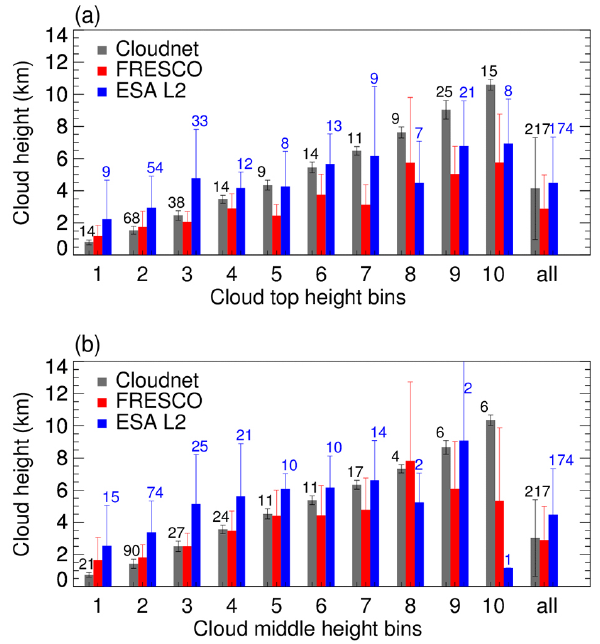
Figure 8. (a) Bar plot of Cloudnet cloud top height, FRESCO cloud height and ESA L2 cloud top height in 1km bins of Cloudnet cloud top height, for single-layer clouds. The height ranges of bins 1–10 are 0–1, 1–2, 2–3, 3–4, 4–5, 5–6, 6–7, 7–8, 8–10, and > 10km. The bin “all” is the mean of bins 1–10. The number above the bar indicates the number of cases; the number of cases for FRESCO is the same as for Cloudnet. The error bar indicates the standard deviation of the data. (b) Same as (a) but for the Cloudnet cloud middle height